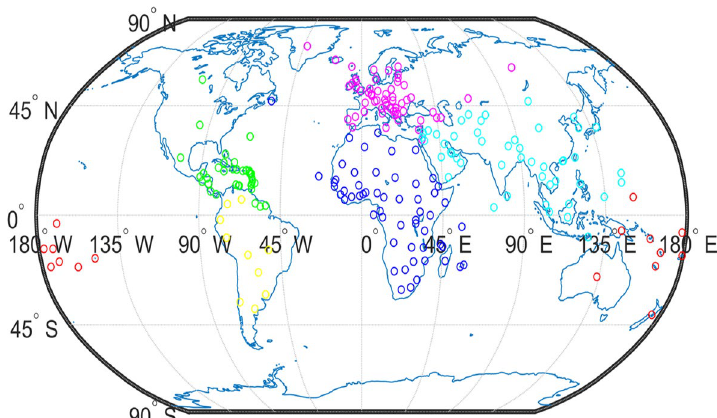
Fig. 7 Football community on the world map. Each color corresponds to one community. Based on the geographical locations of the circles on the map, we observe the following relationship between the confederations and the identified communities: purple: UEFA; blue: CAF; sky blue: AFC; red: OFC; green: CONCACAF; yellow: